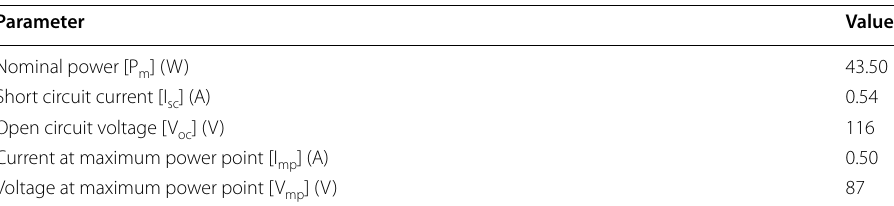
Table 5 Electrical parameter of STPV